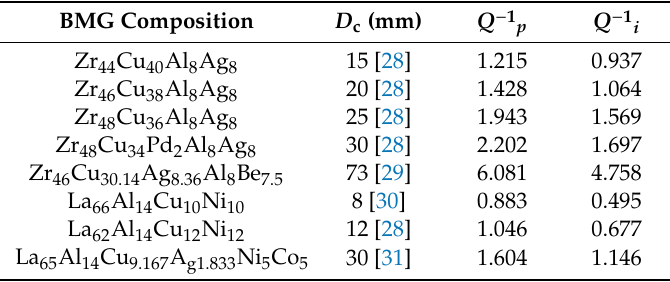
Table 2. The GFA value (determined by the critical parameter [28–31]), IF peak values ( Q p − 1 ) with a driving frequency of 0.5 Hz, and inflection point IF values ( Q i − 1 ) with a driving frequency of 0.5 Hz of Zr-based BMGs and La-based